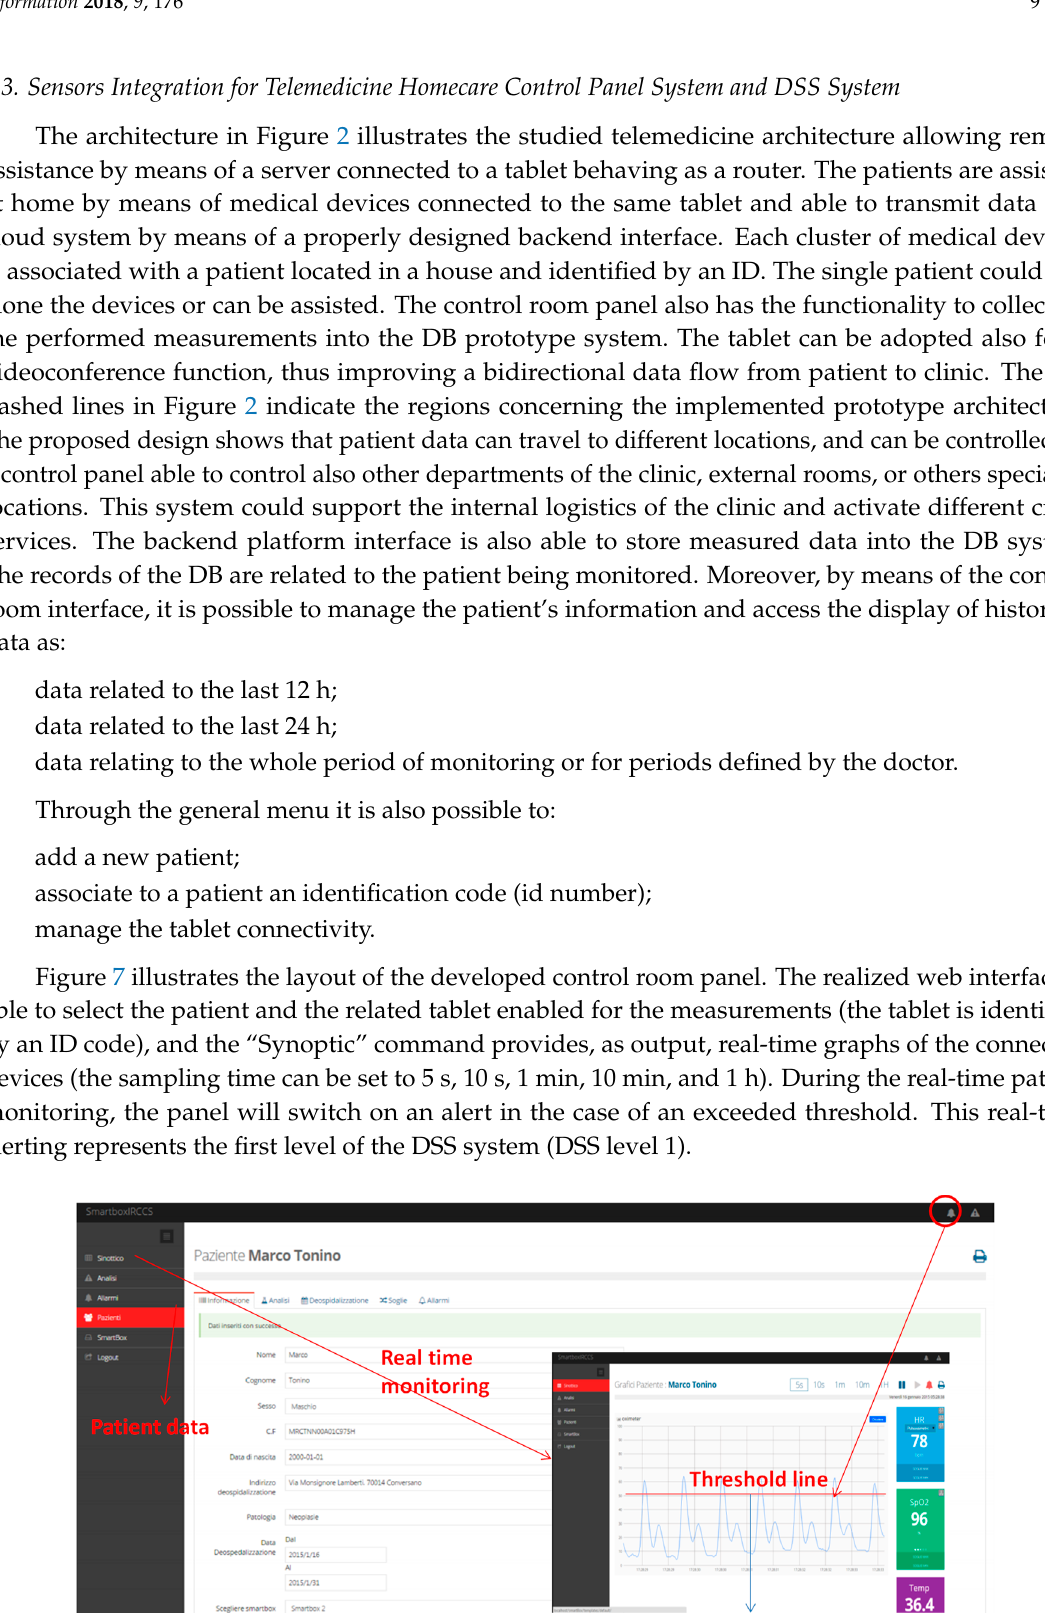
Table 2. Medical devices implemented for homecare assistance.